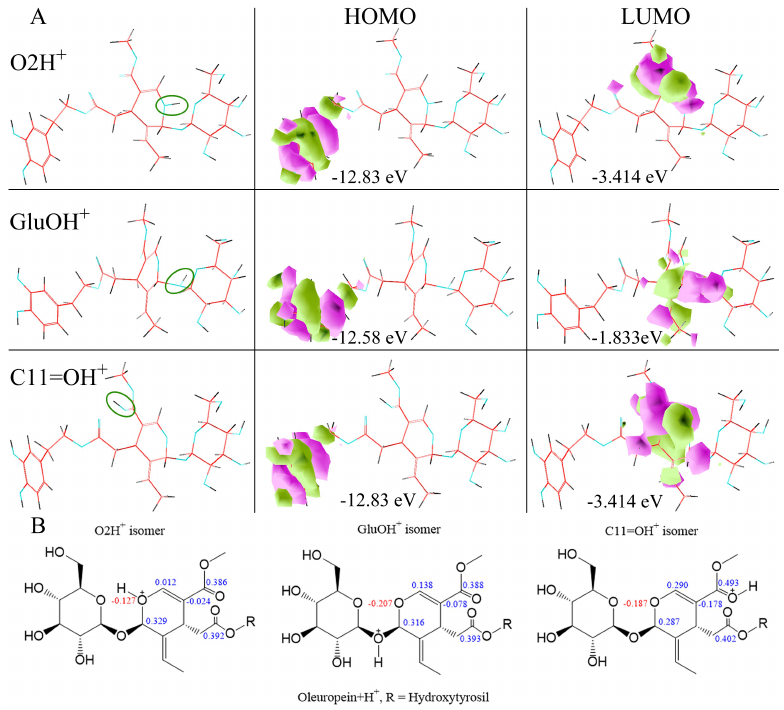
Figure 8. ( A ) Orbital surfaces and energy for HOMO/LUMO of oleuropein + H + isomers, calculated at typed neglected of different overlap (TNDO) level; ( B ) Oleuropein O2 + H + ; oleuropein GluO + H + ; oleuropein C11=O + H + excess charges.